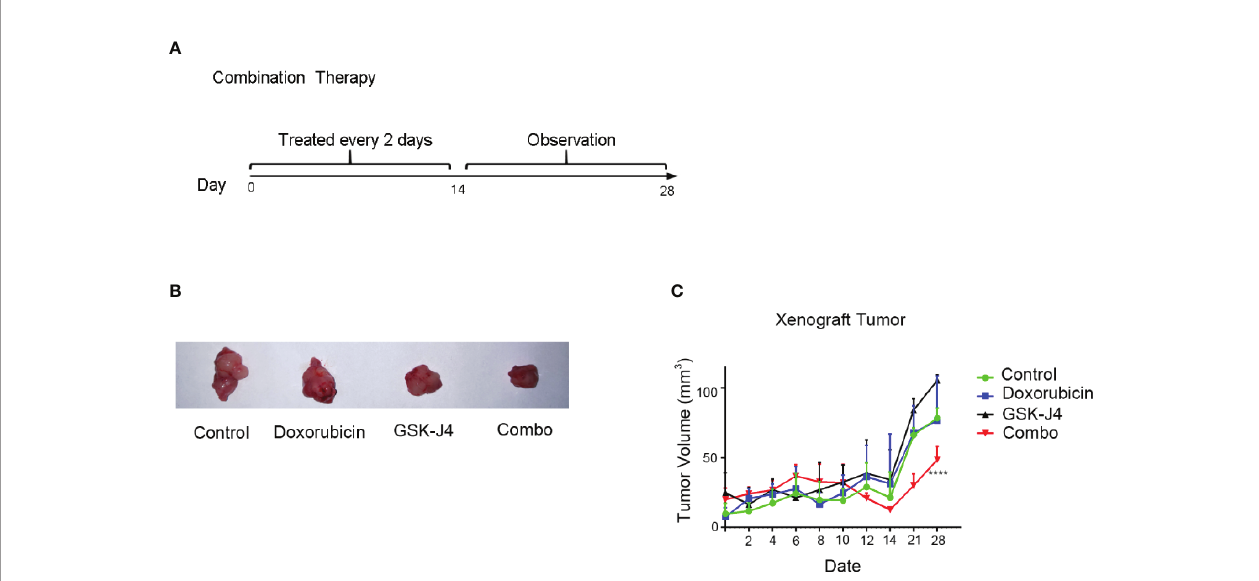
FIGURE 4 | Effect of GSK-J4 combined with doxorubicin on the tumorigenic ability of Cal-62 cells. The schematic diagram of in vivo experiment (A) tumor tissues (B) and volume (C) treated by different experimental